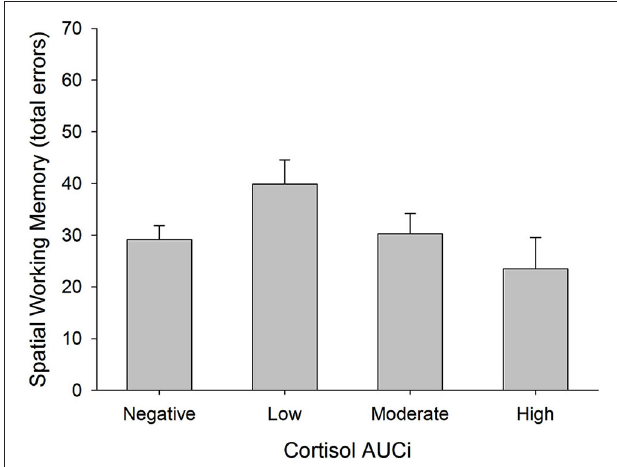
FIGURE 3 | Total errors in Spatial Working Memory test and cortisol reactivity to stress. Participants were divided into four groups: (i) Negative AUCi; (ii) Low first tertile positive AUCi; (iii) Moderate: second tertile positive AUCi; and (iv) High: third tertile positive